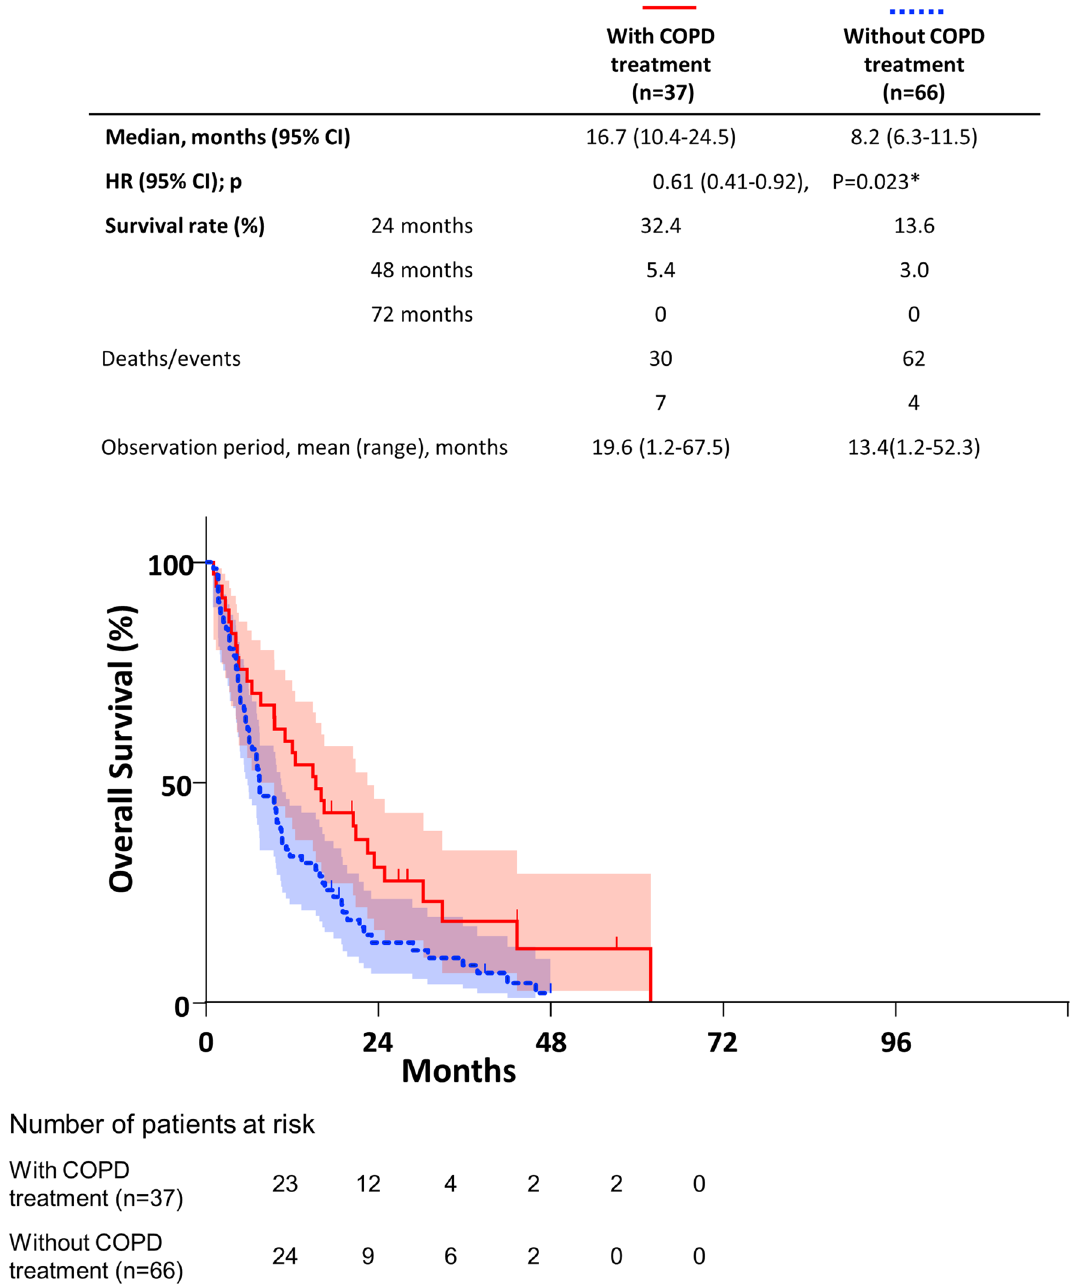
Figure 2. Kaplan–Meier curve of OS stratified by COPD treatment. COPD treatment was associated with a significantly longer OS in advanced NSCLC patients ( P = 0.023*, log-rank test). CI confidence interval, HR hazard